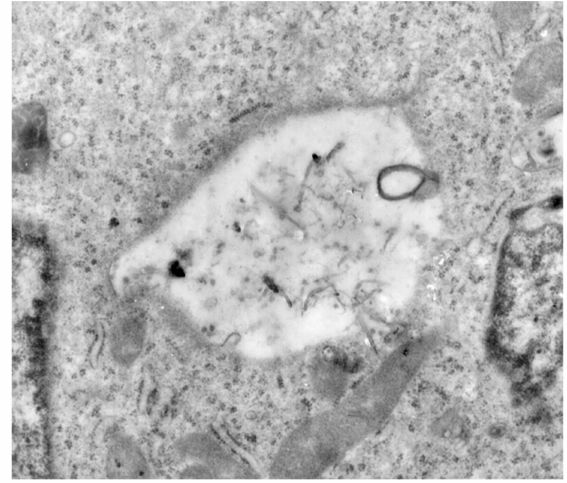
Figure 8. TEM images of EJ28 BCa cells after incubation with 1.51 × 10 − 2 mg mL − 1 CS_MWCNT, proving the presence of nanohybrid within the